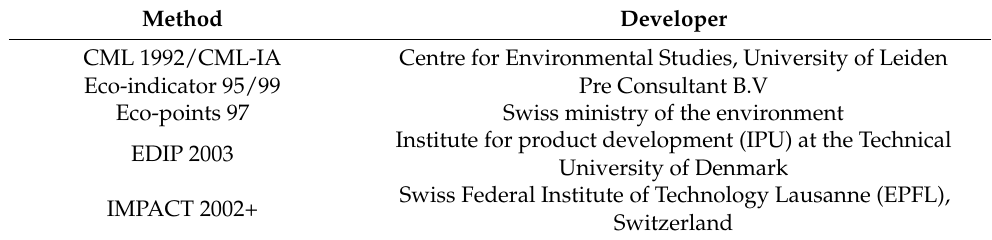
Table 1. List of environmental impact assessment